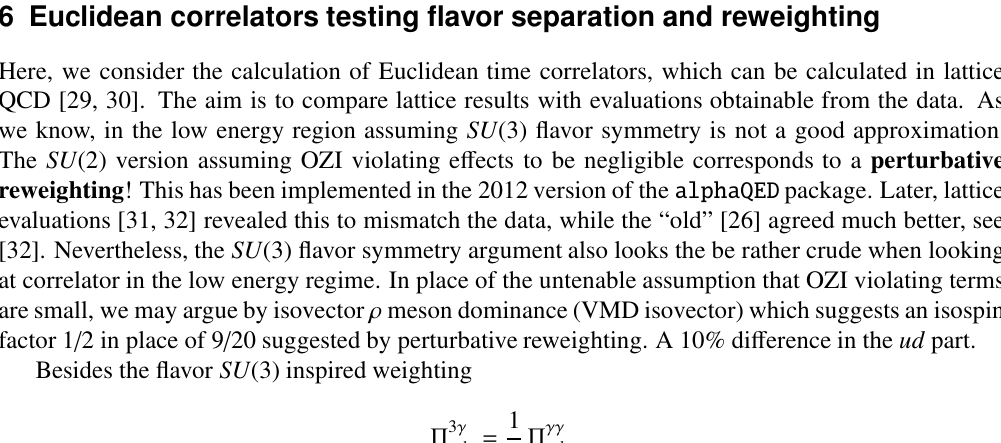
γγ . LQCD tests strongly disfavor h i